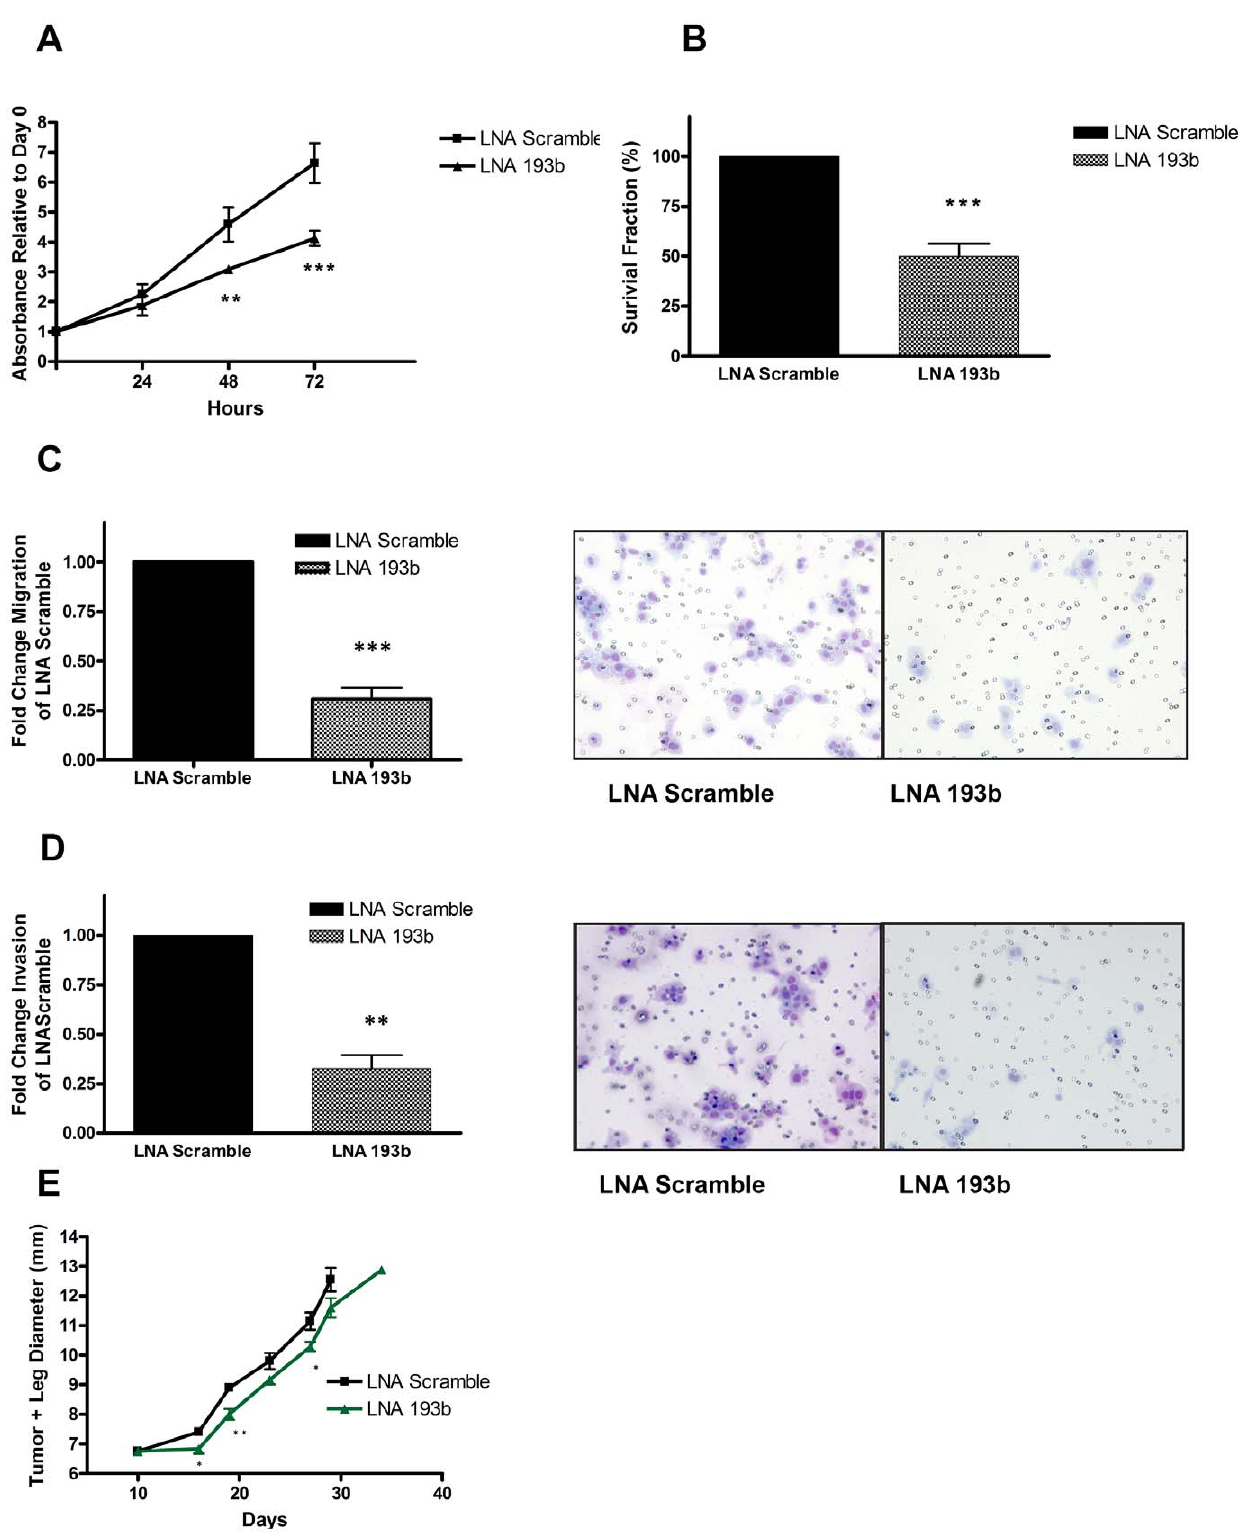
Figure 2. miR-193b downregulation reduced cell proliferation, migration and invasion invitro, and delayed tumor formation invivo . (A) FaDu cells were transfected with 40 nM of LNA-scramble or LNA-193b. Cell viability was assessed in FaDu cells by the MTS assay 24–72 hours post transfection. (B) Clonogenic survival of FaDu cells was measured 10 to 12 days after re-seeding cells treated with LNA-scramble (40 nM) or LNA-193b (40 nM) for 72 hours. (C) Representative images (right) and quantification (left) depicting the reduced ability of FaDu cells to migrate after transfection with LNA-193b (40 nM) compared to LNA-scrambled (40 nM). (D) Representative images (right) and quantification (left) depicting the reduced ability of FaDu cells to invade after transfection with LNA-193b (40 nM) compared to LNA-scrambled (40 nM). (E) FaDu cells were transfected